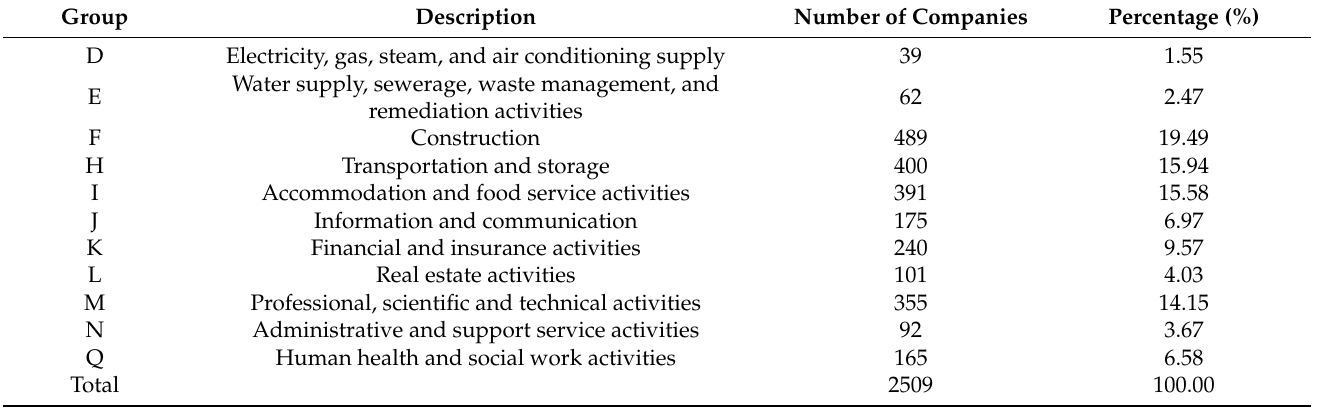
Table 4. Service companies in the sample according to the International Standard Industrial